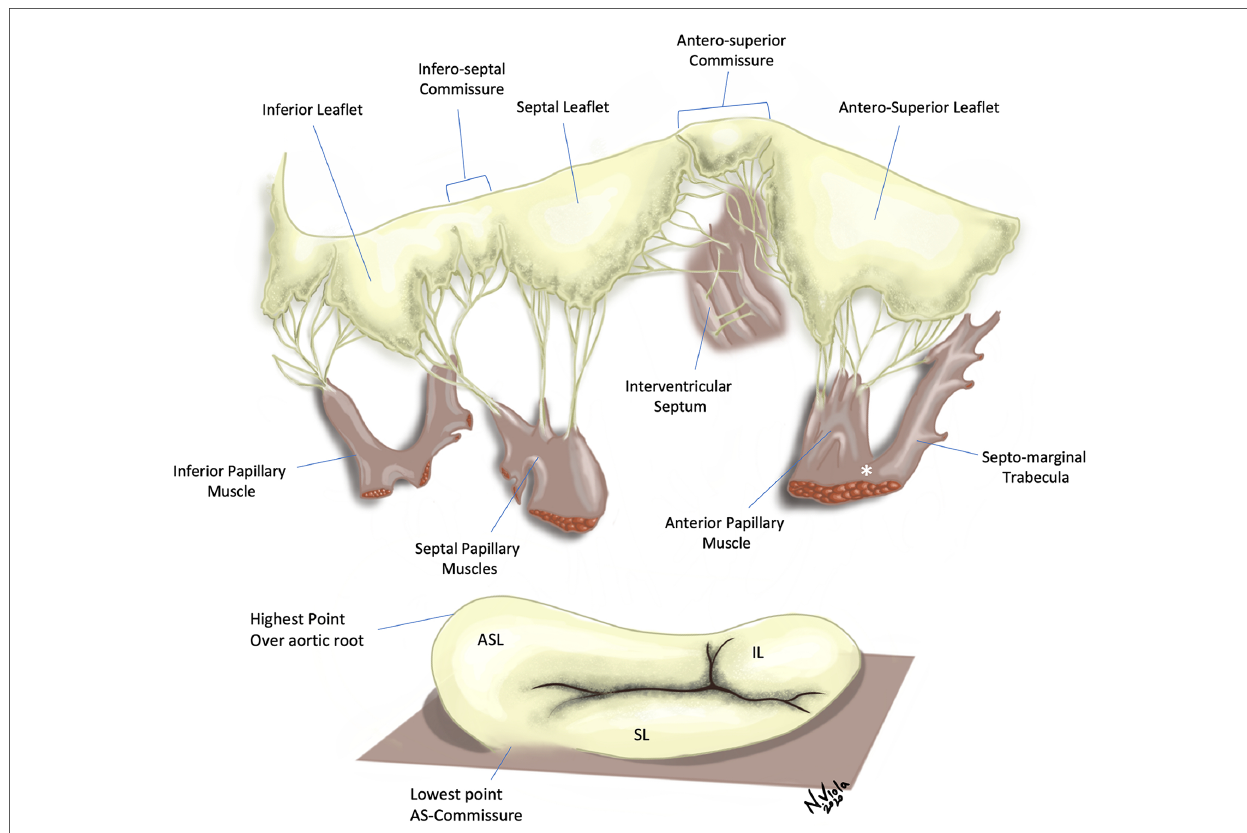
FIGURE 1 Tricuspid valve with lea fl ets and subvalvar apparatus. Top Panel — Several chordal attachments to the interventricular septum can be seen, both directly or through small septal papillary muscles. The anterior papillary muscle is connected to the septo-marginal trabecula via the moderator band (*). Bottom Panel — The tricuspid valve annulus has a wave-like, saddle-shaped form. Note the lack of discernible annulus in proximity of the antero-septal commissure. ASL, Antero-superior lea fl et; SL, Septal lea fl et; IL, Inferior lea fl